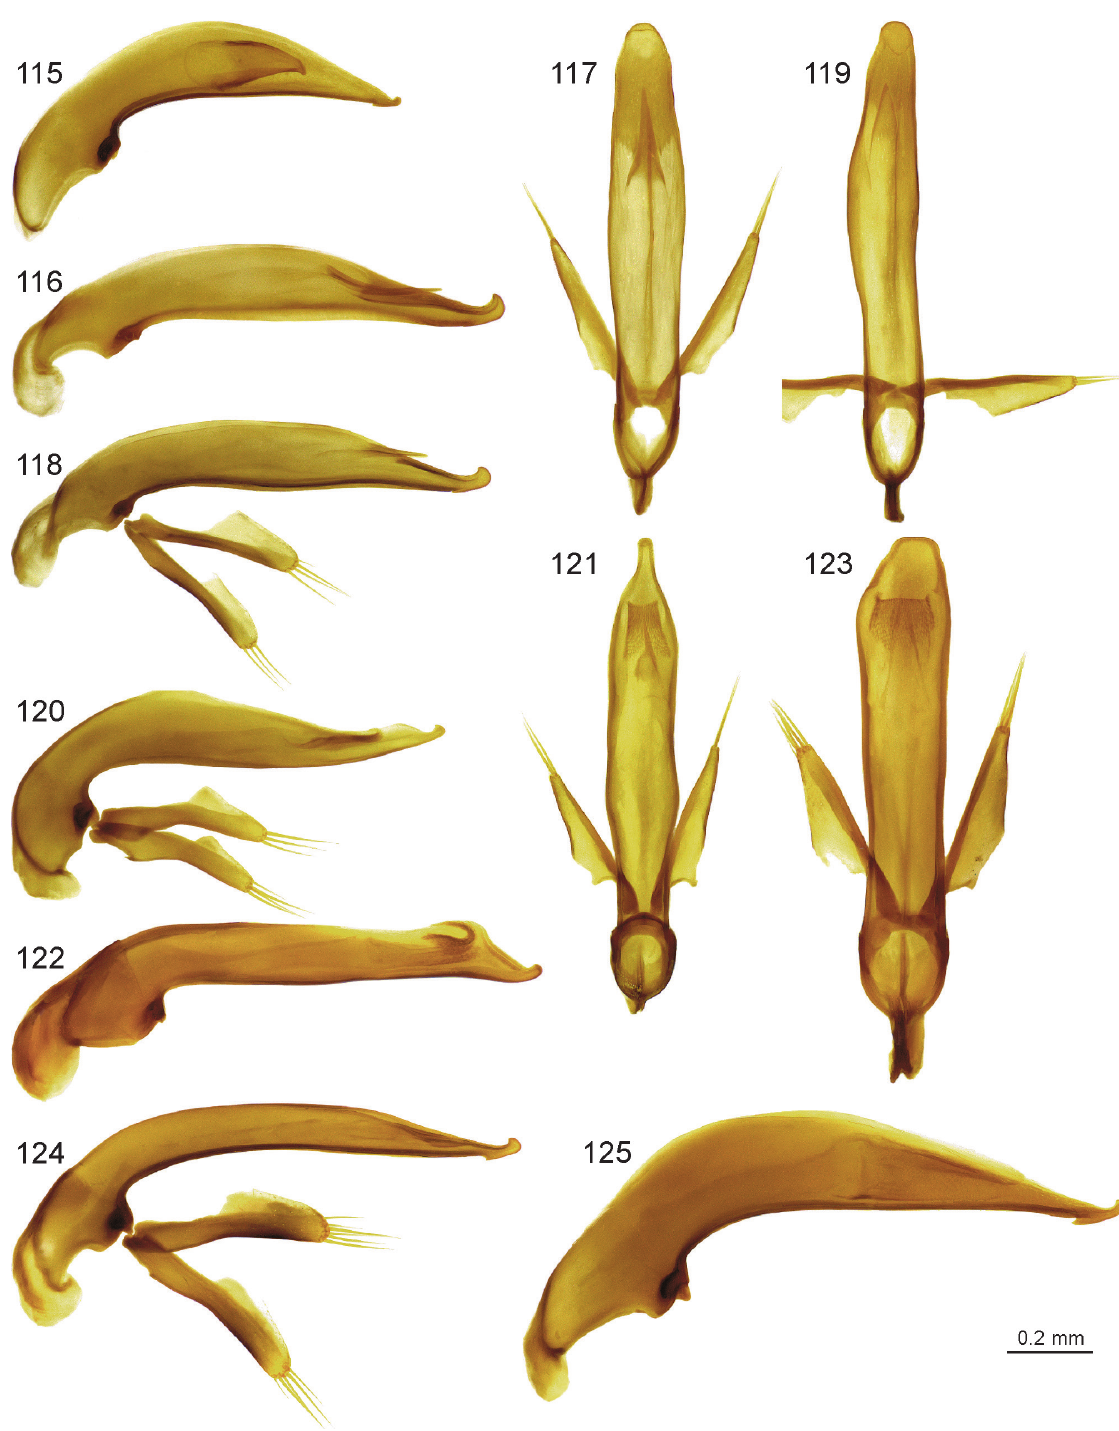
Figs 115–125. Trechus spp., aedeagal median lobe, left lateral view (115–116, 118, 120, 122, 124–125) and dorsal view (117, 119, 121, 123). 115 . T. depressipennis sp. nov., holotype. 116–117 . T.